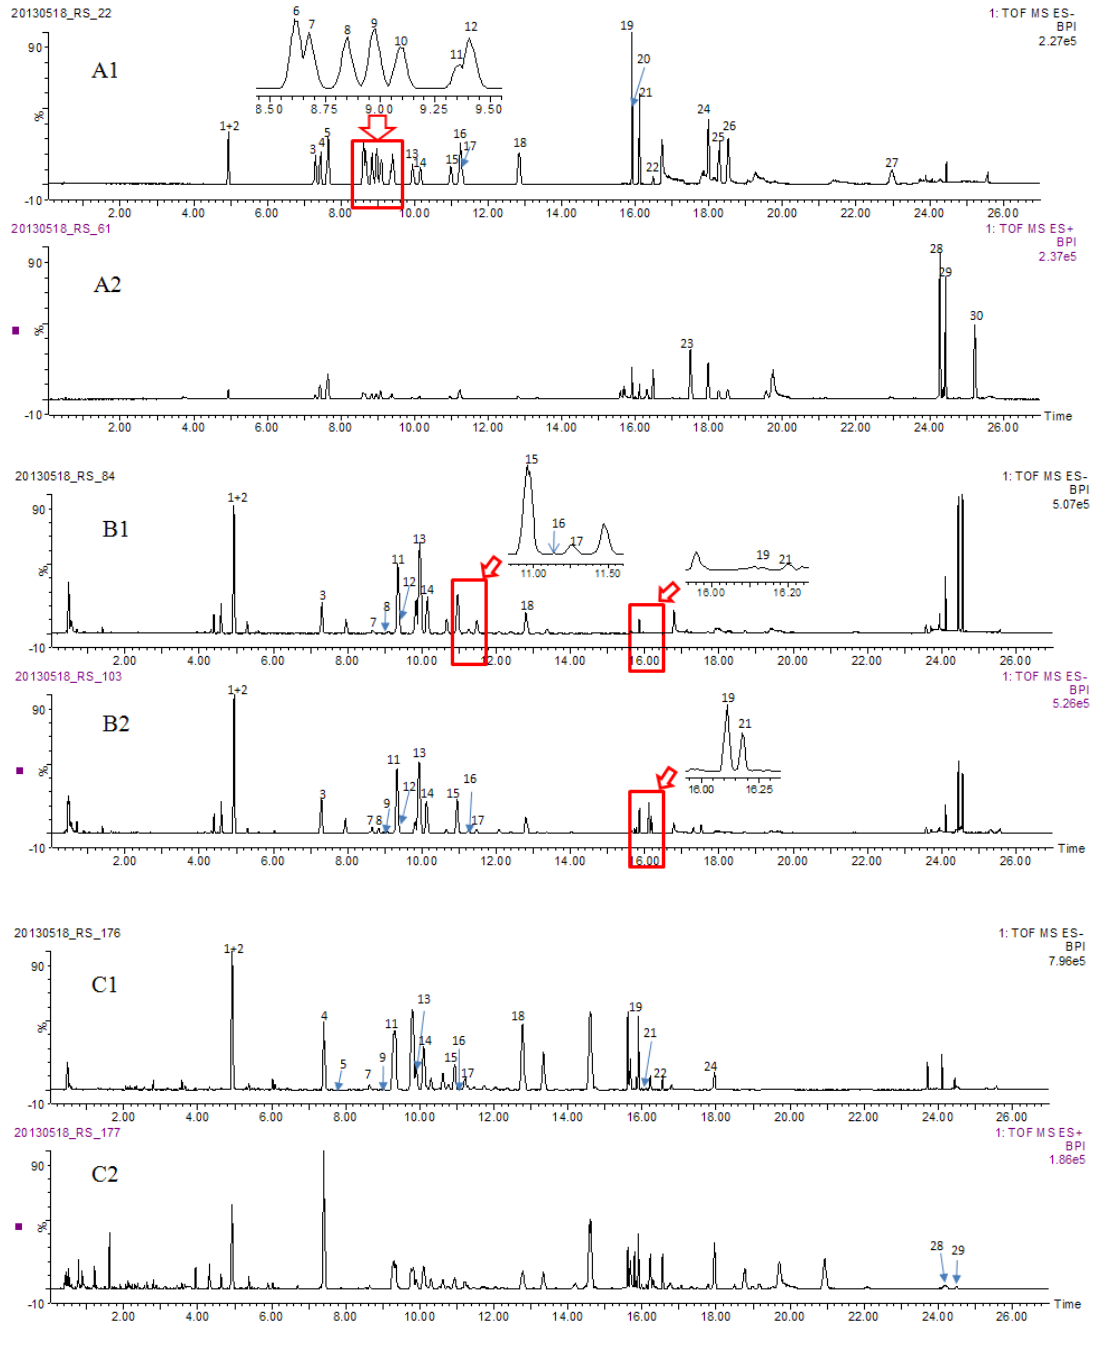
Figure 2. BPI chromatograms of reference compounds, the methanol extracts and the decoctions (Du-Shen-Tang) of ASG and AMG by UHPLC–QTOF–MS/MS analysis. A: Chromatograms of 30 reference compounds in negative ( A1 ) and positive ( A2 ) ion mode; B: Chromatograms of the methanol extract ( B1 ) and the decoction ( B2 ) of ASG in negative ion mode; C: Chromatograms of the methanol extract of AMG in negative ion mode ( C1 ) and positive ion mode ( C2 ); D: Chromatograms of the decoction of AMG in negative ion mode ( D1 ) and positive ion mode ( D2 ). Compound codes are the same as those in Figure